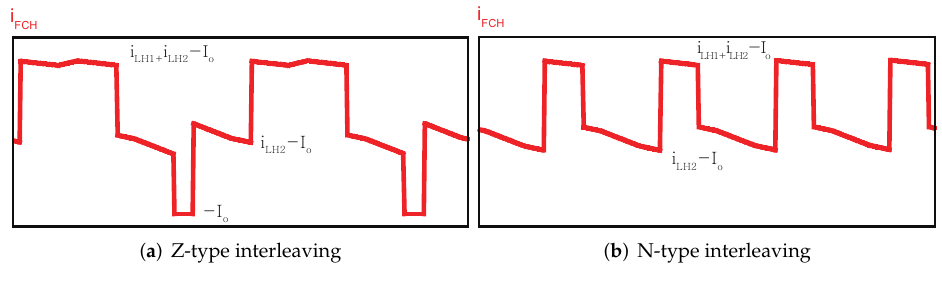
Figure 10. Capacitor current